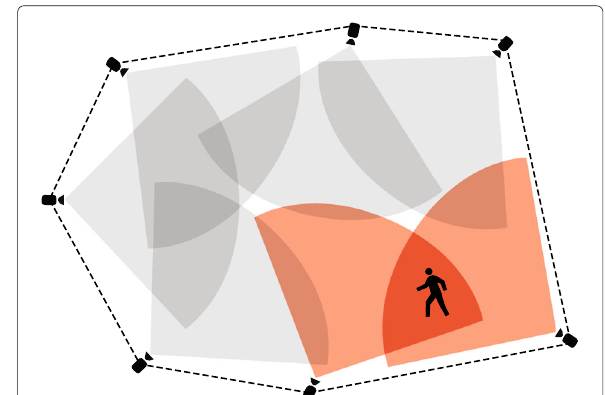
Fig. 1 Camera network with seven nodes with limited sensing and communication ranges. Thedashedlinesrepresent the communication channels between different nodes. The target is observable by two cameras at the given time